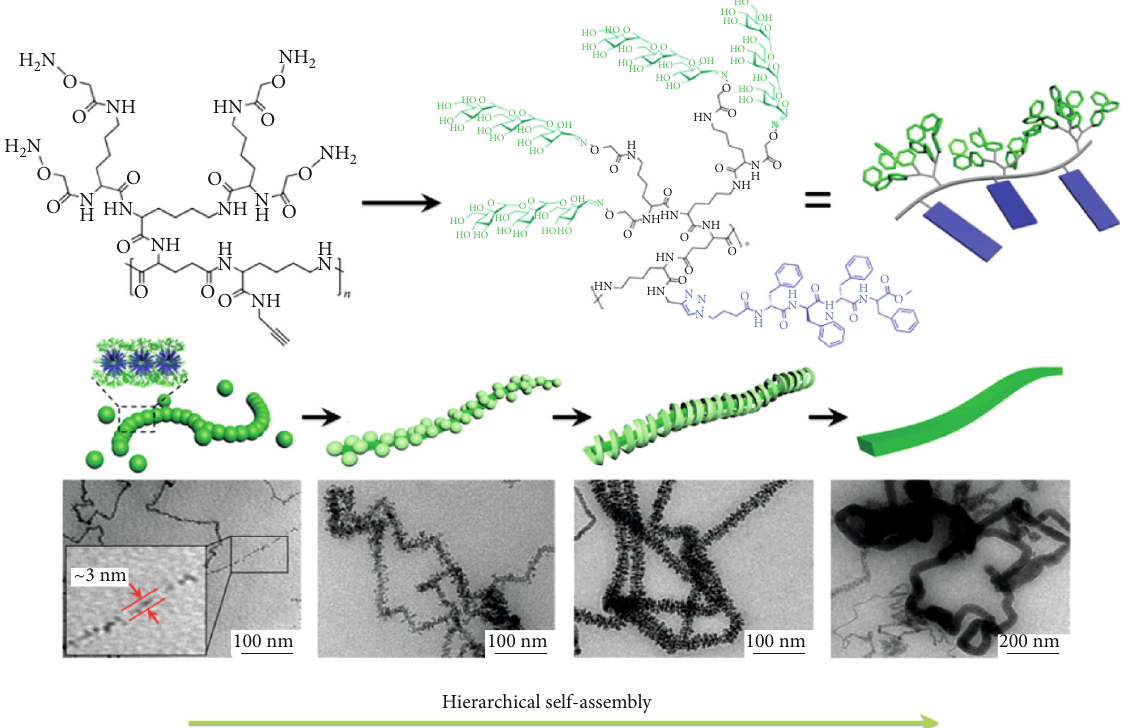
Figure 6: Synthesis and chemical structure of alternating amphiphilic glycopolypeptide brushes (AAGB) with glycodendron and oligopeptide pendants and their schematic illustration as well as TEM images of the hierarchical self-assembly process (reprinted with permission from Ref. [76]; copyright (2016) American Chemical